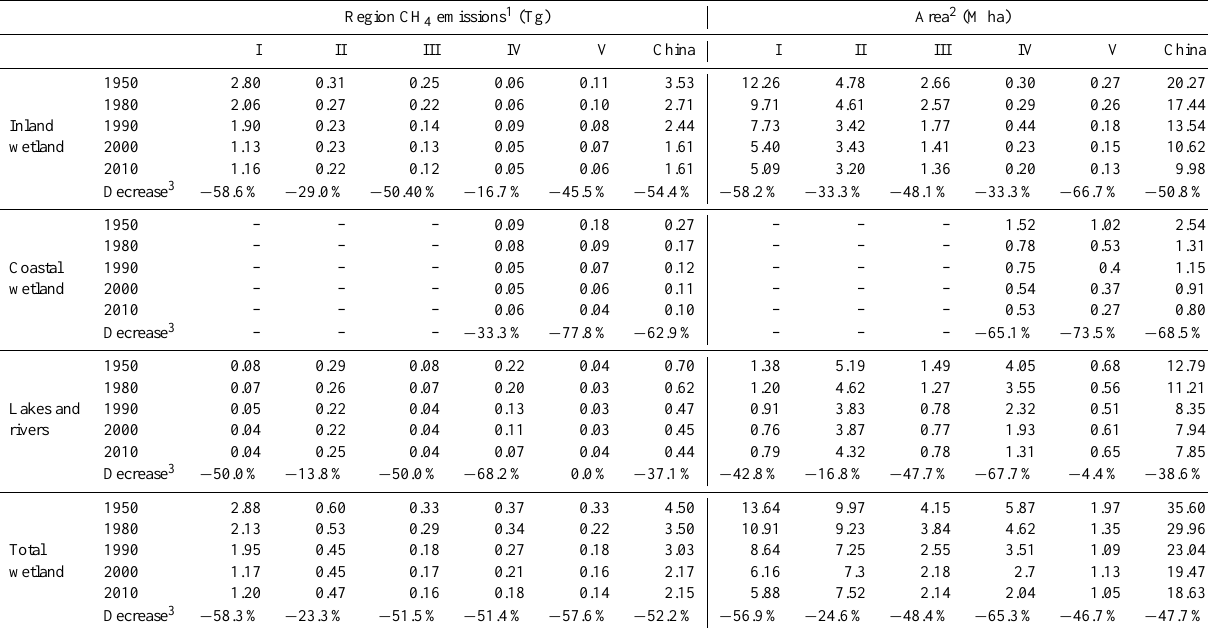
Table 2. Regional CH 4 emissions and the wetland